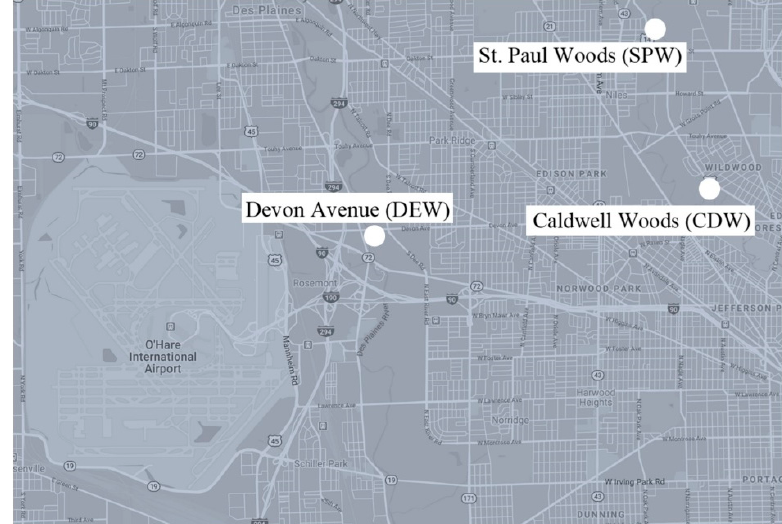
Figure 1. Combined sewer outfall (CSO) sampling locations in the Greater Chicago Area.